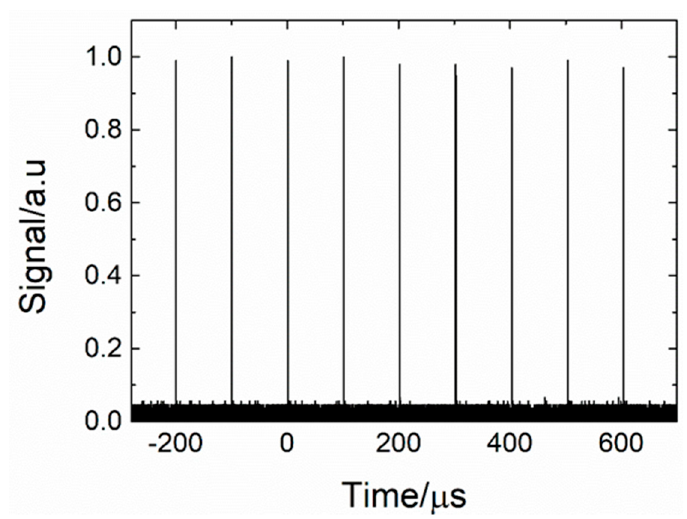
Figure 7. Typical 2.78 µm pulse train of a repetition rate of 10 kHz measured for a launched pump power of 3.27 W. The fiber length used in this experiment was L = 1.1 m.